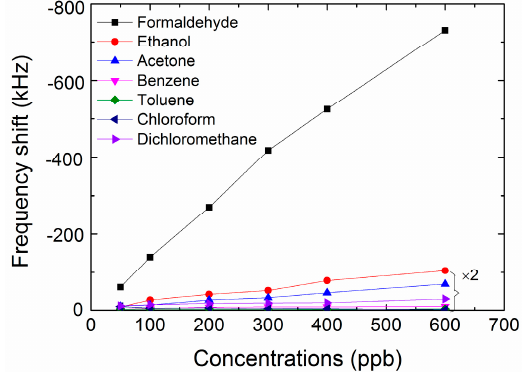
Figure 10. Plots of the frequency shift as a function of different concentration for formaldehyde and potential indoor pollution vapors.